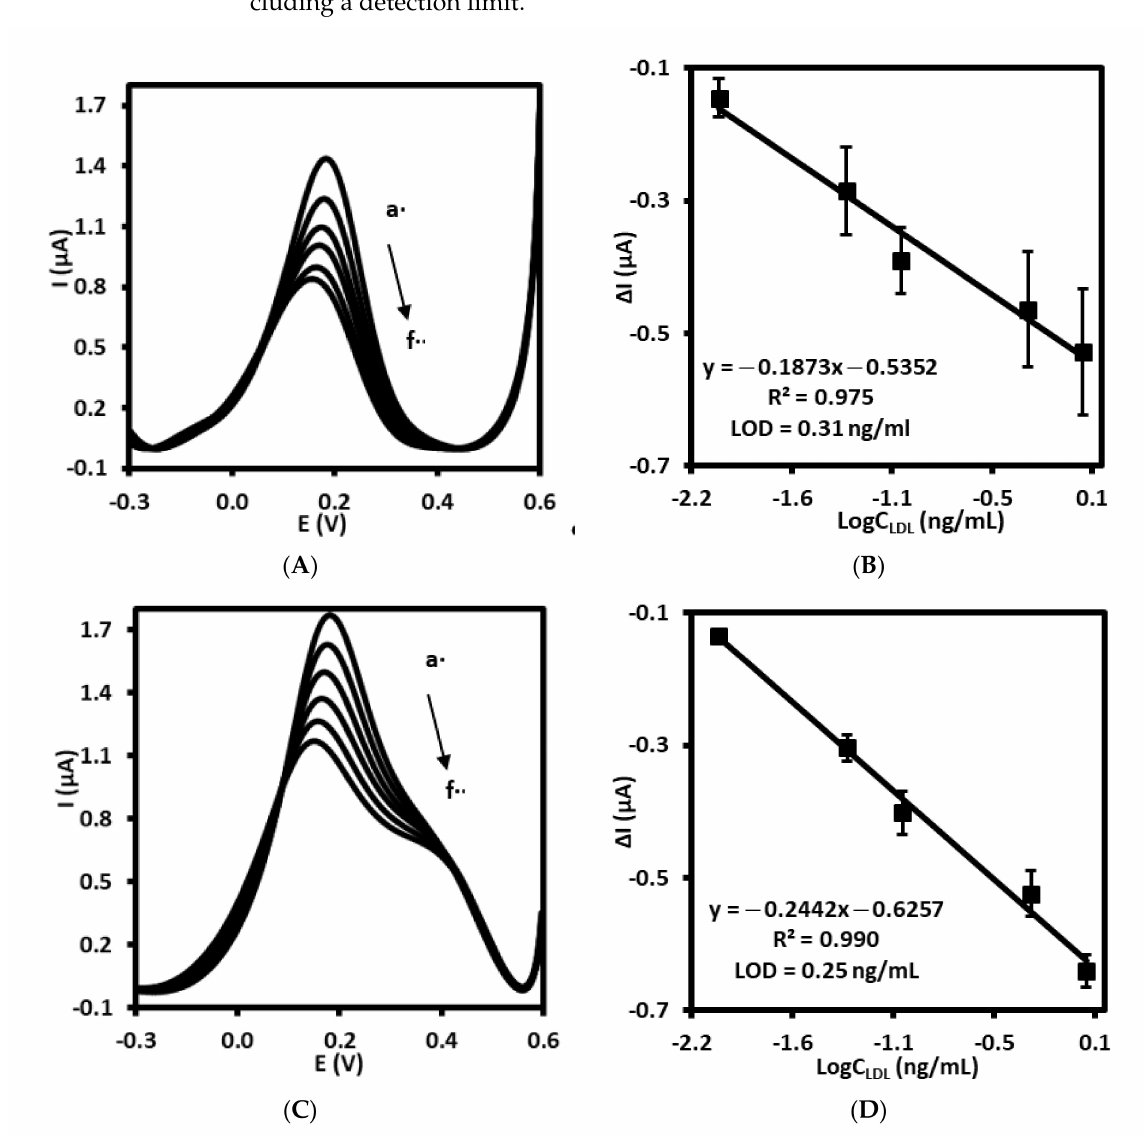
Figure 4. Square wave voltammograms recorded for ( A ) immunosensor and ( C ) aptasensor upon treatment with LDL standard solution with different concentration, a: 0.0, b: 0.01, c: 0.05, d: 0.1, e: 0.5, f: 1.0 ng/mL in PBS (pH 7.4) with 1 mM [Fe(CN) 6 ] 3 − /4 − . The calibration curves of ( B ) immunosensor and ( D ) aptasensor for LDL